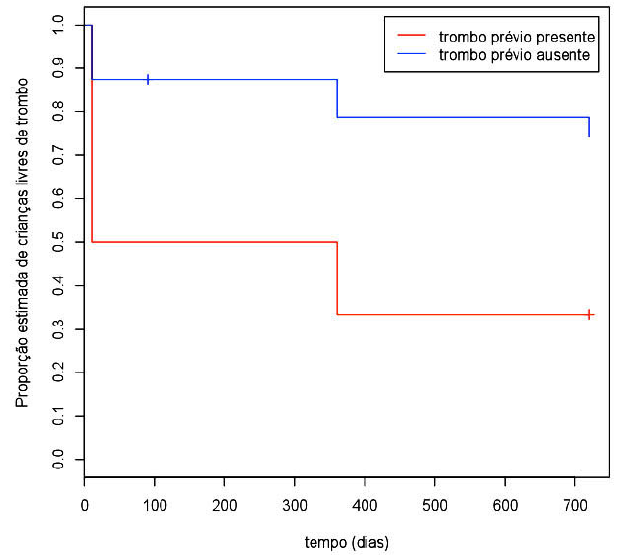
Fig.2 - Thrombus-free survival curve comparing patients with history of prior occurrence of thrombus and without occurrence of thrombus.